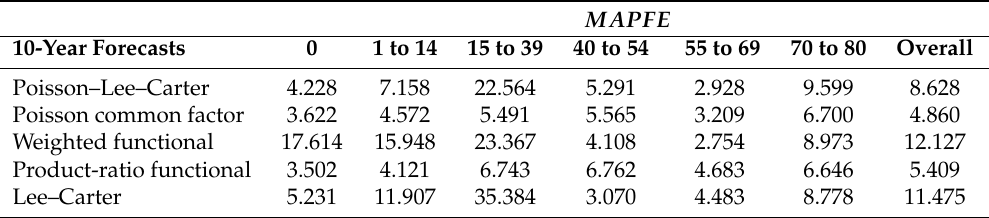
Table 7. Mean Absolute Percentage Forecast Error ( MAPFE ) of male-to-female death rate ratios by age and method for Malaysia.